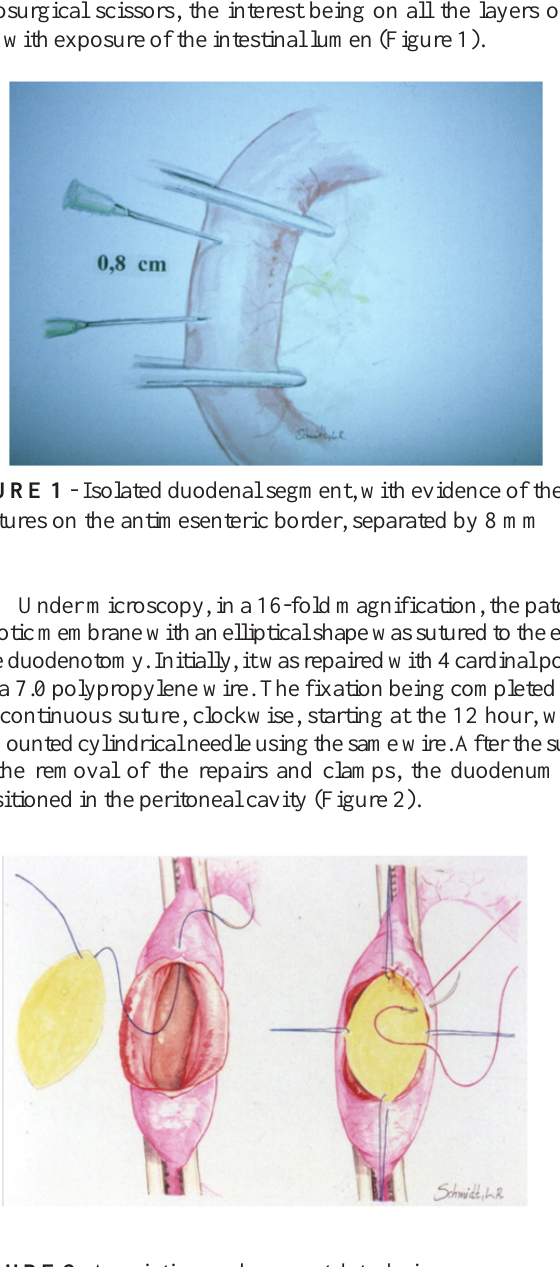
FIGURE 2 - Amniotic membrane patch